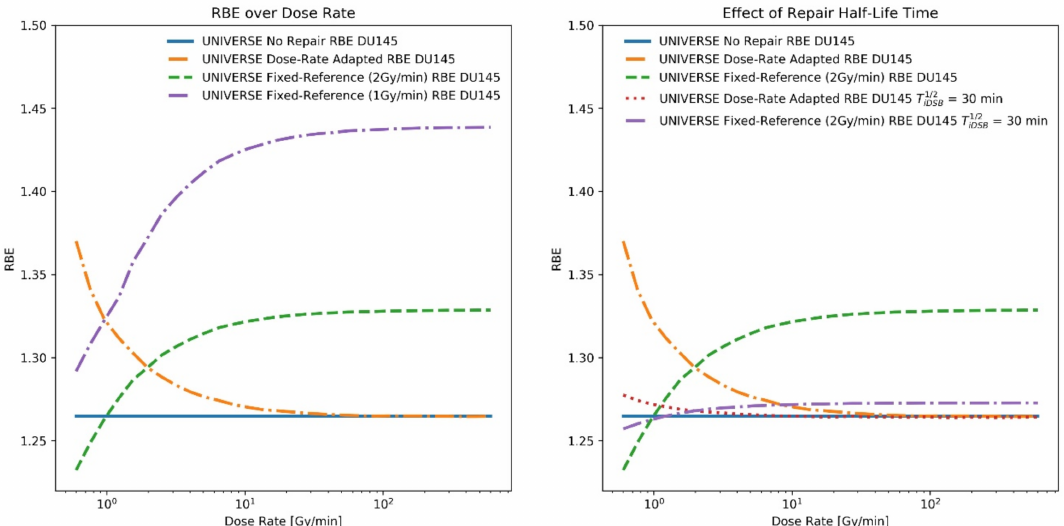
Figure 3. Proton RBE predictions for the DU145 cell-line over the applied dose rate for the fixed- reference RBE (2 Gy/min; green dashed line) as well as the dose-rate adapted RBE (dotted orange line) at 6 Gy and 8 kev/ µ m. The predicted no-repair RBE is shown for reference (solid lines). Left panel: An additional prediction for the same cell-line is shown, calculated based on a reference radiation source with a reduced fixed dose rate (1 Gy/min). Right panel: Additional predictions are shown for the same cell-line but a larger value for T 1/2 (=30 iDSB